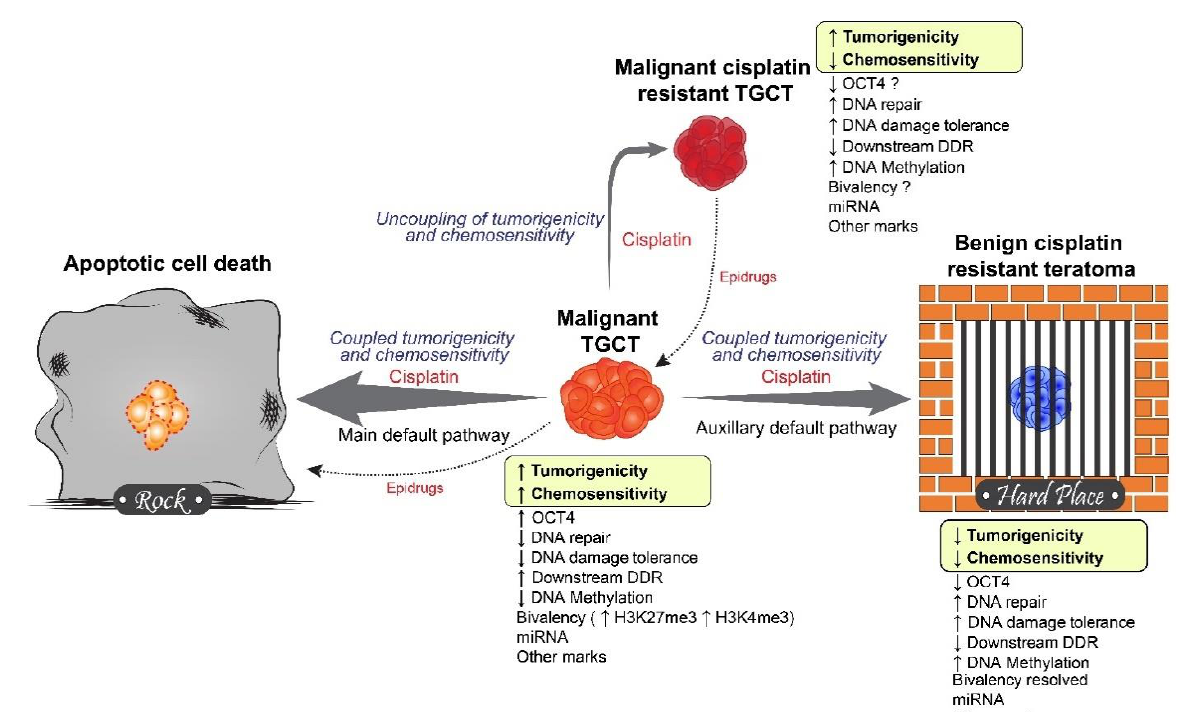
Figure 2. Rock and a hard place model of TGCT chemosensitivity. The model speculates that an explanation for why TGCTs are so sensitive to cisplatin-based therapy compared to other solid tumors is that the very epigenetic state(s) that drives tumorigenicity are the same or “linked” to the epigenetic state(s) that drive chemosensitivity. In such a model there are two main outcomes for cisplatin treated TGCTs; to either die or differentiate (in the extreme case to benign teratoma). This situation is predicted not to occur in other solid tumor types, or their cancer stem cells. In rare cases the epigenetic state driving tumorigenicity of TGCTs becomes uncoupled from the epigenetic state driving chemosensitivity resulting in cisplatin resistant TGCTs that retain tumorigenicity. Epigenetic drugs have the potential to “recouple” chemosensitivity with tumorigenicity or to target unique epigenetic vulnerabilities of TGCTs directly. Epigenetic drugs that cause teratoma formation would not be optimal as teratoma is still a clinical issue necessitating surgical removal.